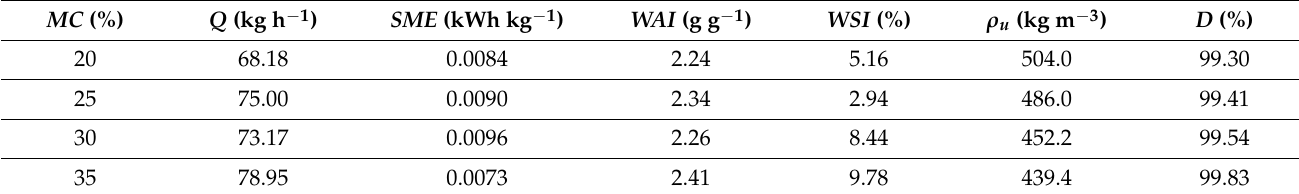
Table 1. Results of measurements of the physical properties of pelleted corn